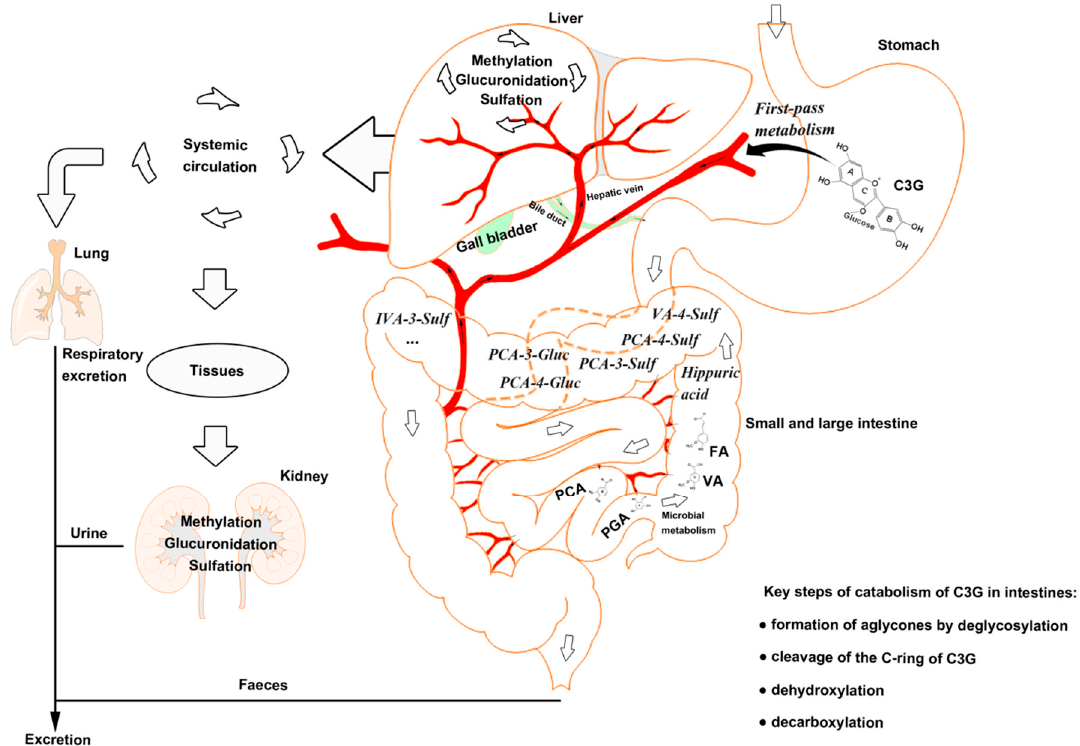
Figure 1. The catabolism process of cyanidin-3-glucoside (C3G) in an organism. C3G can be hydrolyzed to its aglycone by enzymes in the small intestine, and further degraded to phenolic compounds by gut microbiota. Microbial catabolism of C3G in the distal small intestine and large intestine is performed by the cleavage of the heterocyclic flavylium ring (C-ring), followed by dehydroxylation or decarboxylation to form multistage metabolites, which enter the liver and kidney by circulation. C3G, cyanidin-3-glucoside; FA, ferulic acid; PCA, protocatechuic acid; PGA, phloroglucinaldehyde; VA, vanillic acid.